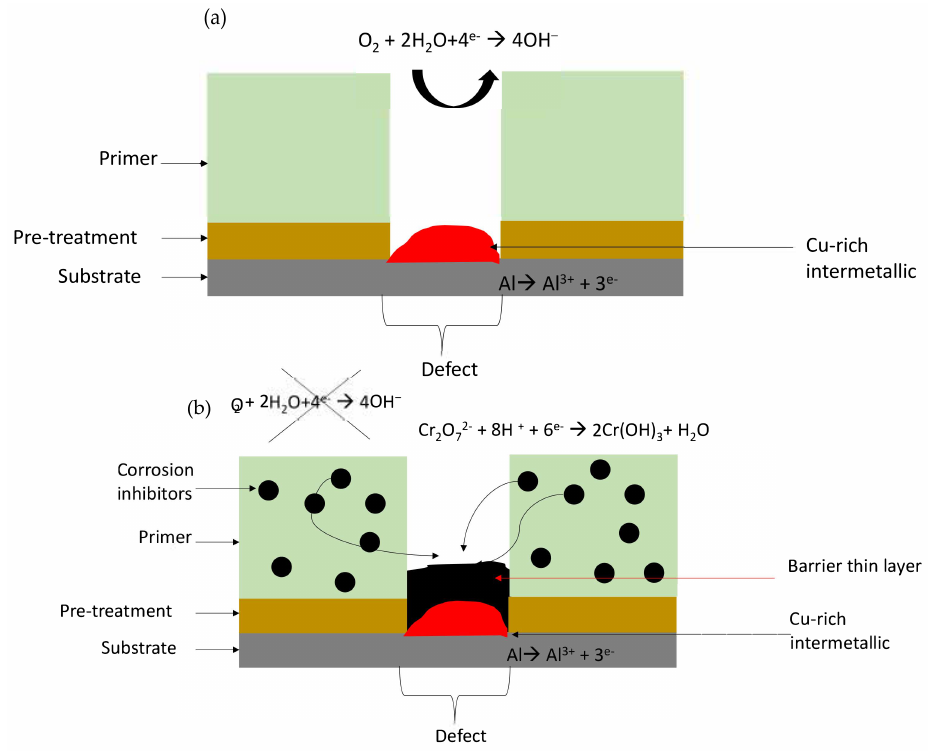
Figure 6. Scheme representing the mechanisms of corrosion ( a ) and protection by Cr(VI) ( b ) of aluminum